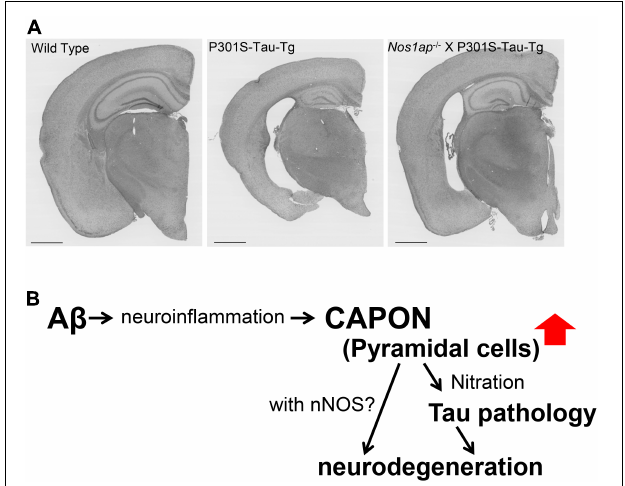
FIGURE 12 | Photograph of common marmosets ( Callithrix jacchus ). The photo shows members of captive common marmoset family. Their small body size, fecundity, and high cognitive functions are a suitable model for neuroscience. The photograph of marmosets was taken by WK at